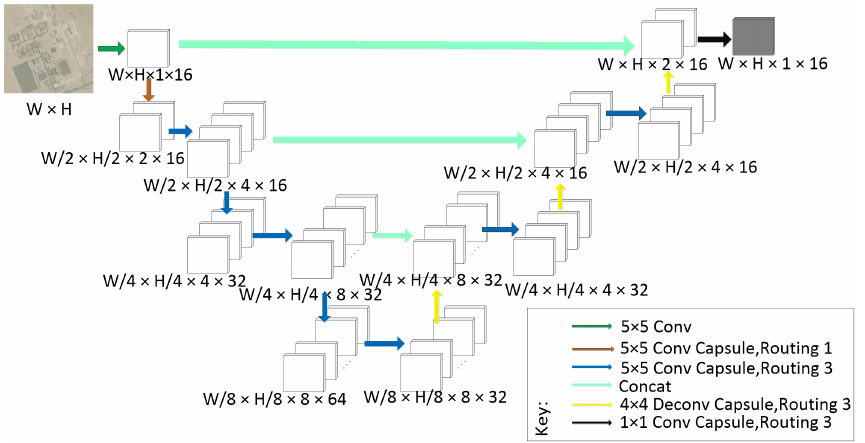
Figure 5. The backbone of a change capsule network.